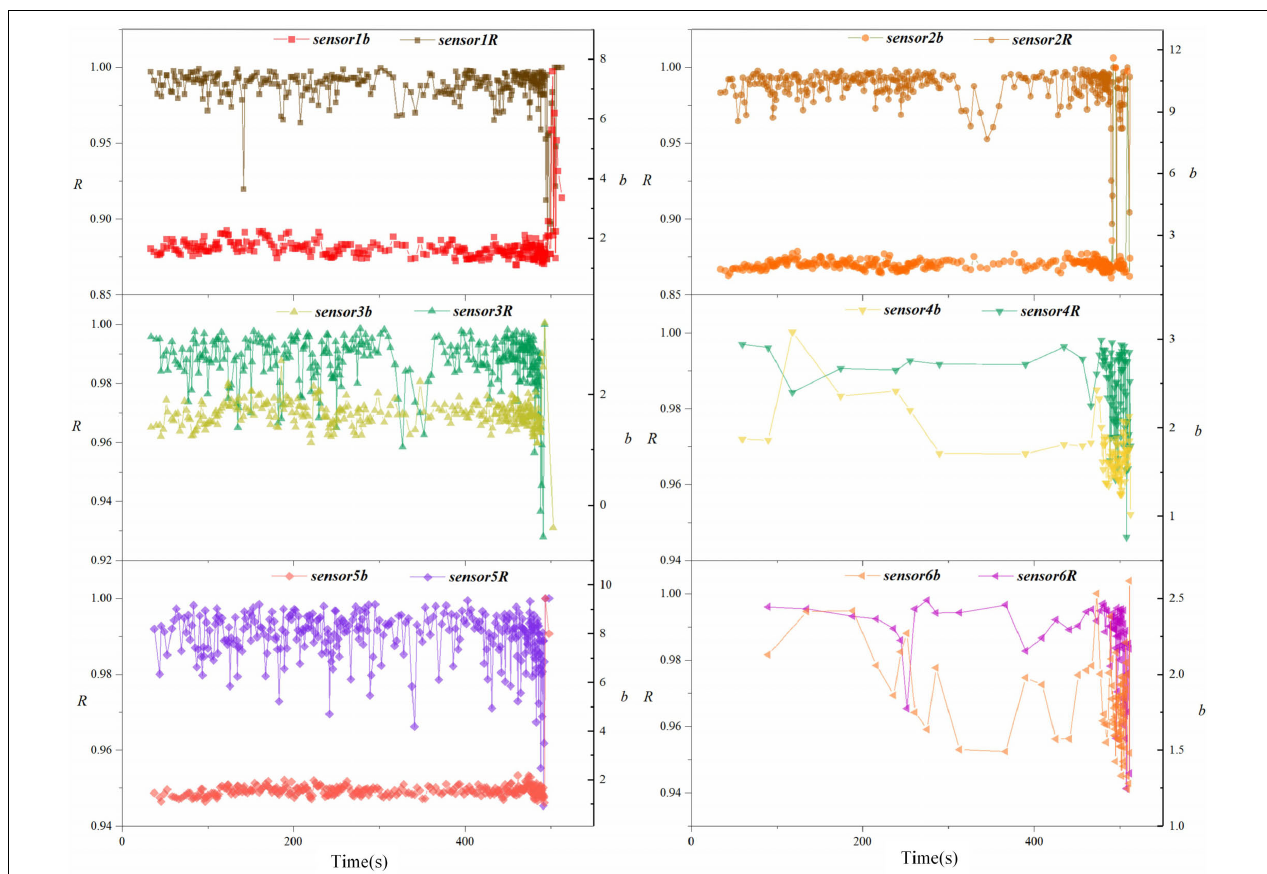
FIGURE 2 | AE b value curve of dry granite calculated by AE hit. The b values were calculated by the AE hit monitored by six of all the sensors, and the fitted value R of the b value was obtained. These AE signals did not remove noise.